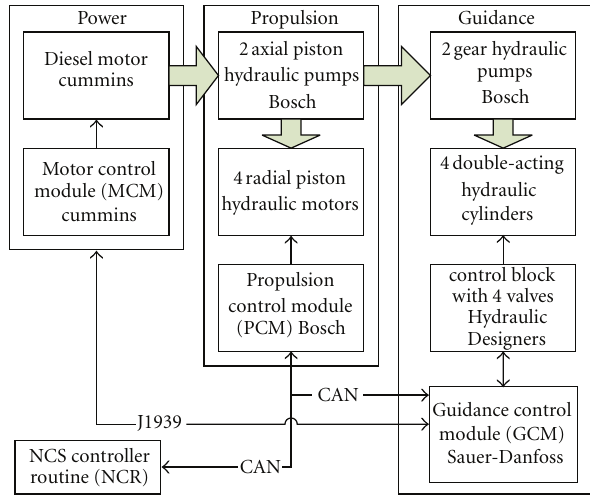
Figure 2: Electromechanical schematic view of the robotic plat-